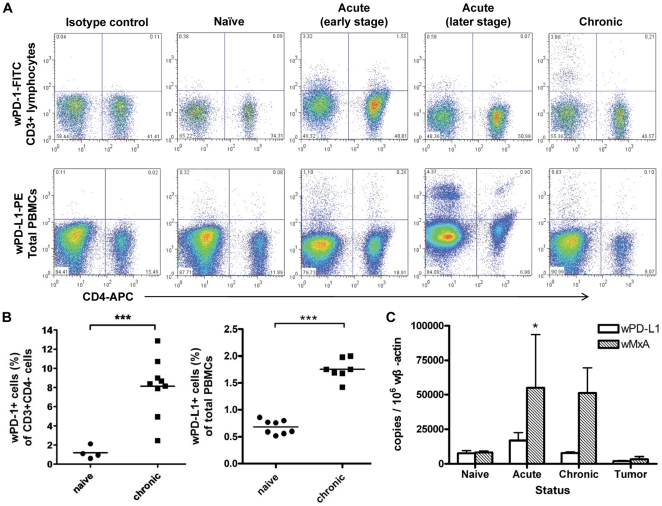
WPD-1 and wPD-L1 expression during WHV infection.Naïve, acutely and chronically WHV-infected woodchucks were examined for wPD-1 and PD-L1 expression on PBMCs and in liver tissue. (A) The expression of wPD-1 on CD3+ cells and wPD-L1 on total PBMCs from woodchucks with different status of WHV infection. (B) The expression of wPD-1 and wPD-L1 on woodchuck PBMCs was compared in naive and chronically infected woodchucks by flow cytometry analysis.. (C) Liver tissue was collected from naïve woodchucks (n = 4), woodchucks with acute (n = 5), chronic (n = 7) WHV infection, HCC tissue and peritumoural tissue (n = 3). Total mRNAs were extracted from the liver tissue and subjected to real time RT-PCR for wPD-L1 and wMxA expression. The stastical analysis was performed to compare the gene expression levels in different animals with the naïve animals as reference. The statistical significance of the results was given as P values: *, p<0.05; **, p<0.005; ***, p<0.0005.